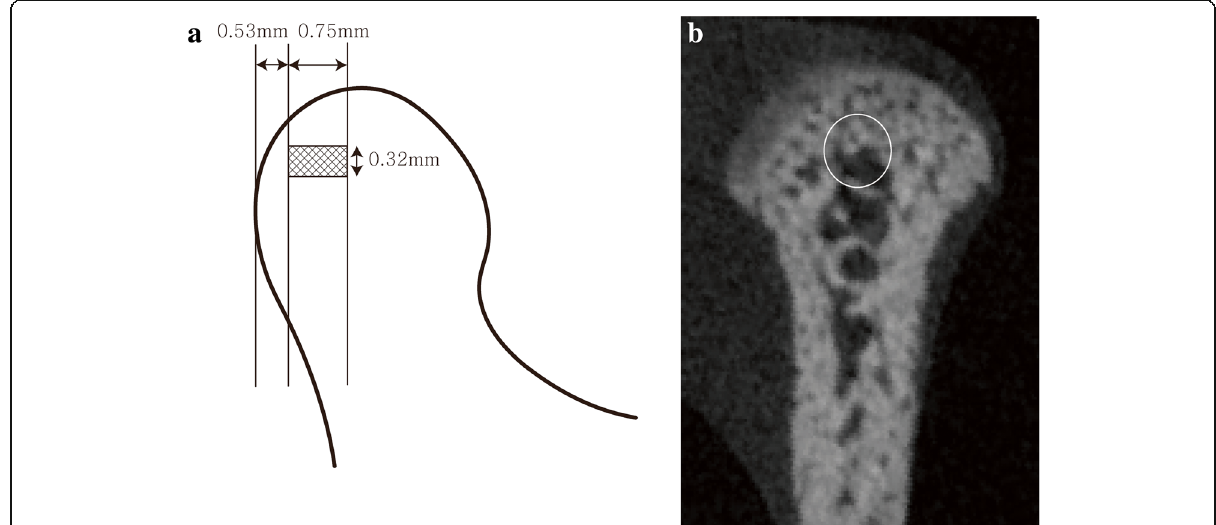
Fig. 2 Range of analysis ( a ) and region of interest (ROI) ( b ). The region of interest (ROI) was focused between 0.53 and 1.28 mm from the most posterior margin of the condyle. Then, a 0.32 mm × 0.32 mm sized circle was set at the center of the condyle. Finally, cylindrical shape was formed at the condyle area (0.32 mm diameter and 0.75 mm height), and this area was analyzed